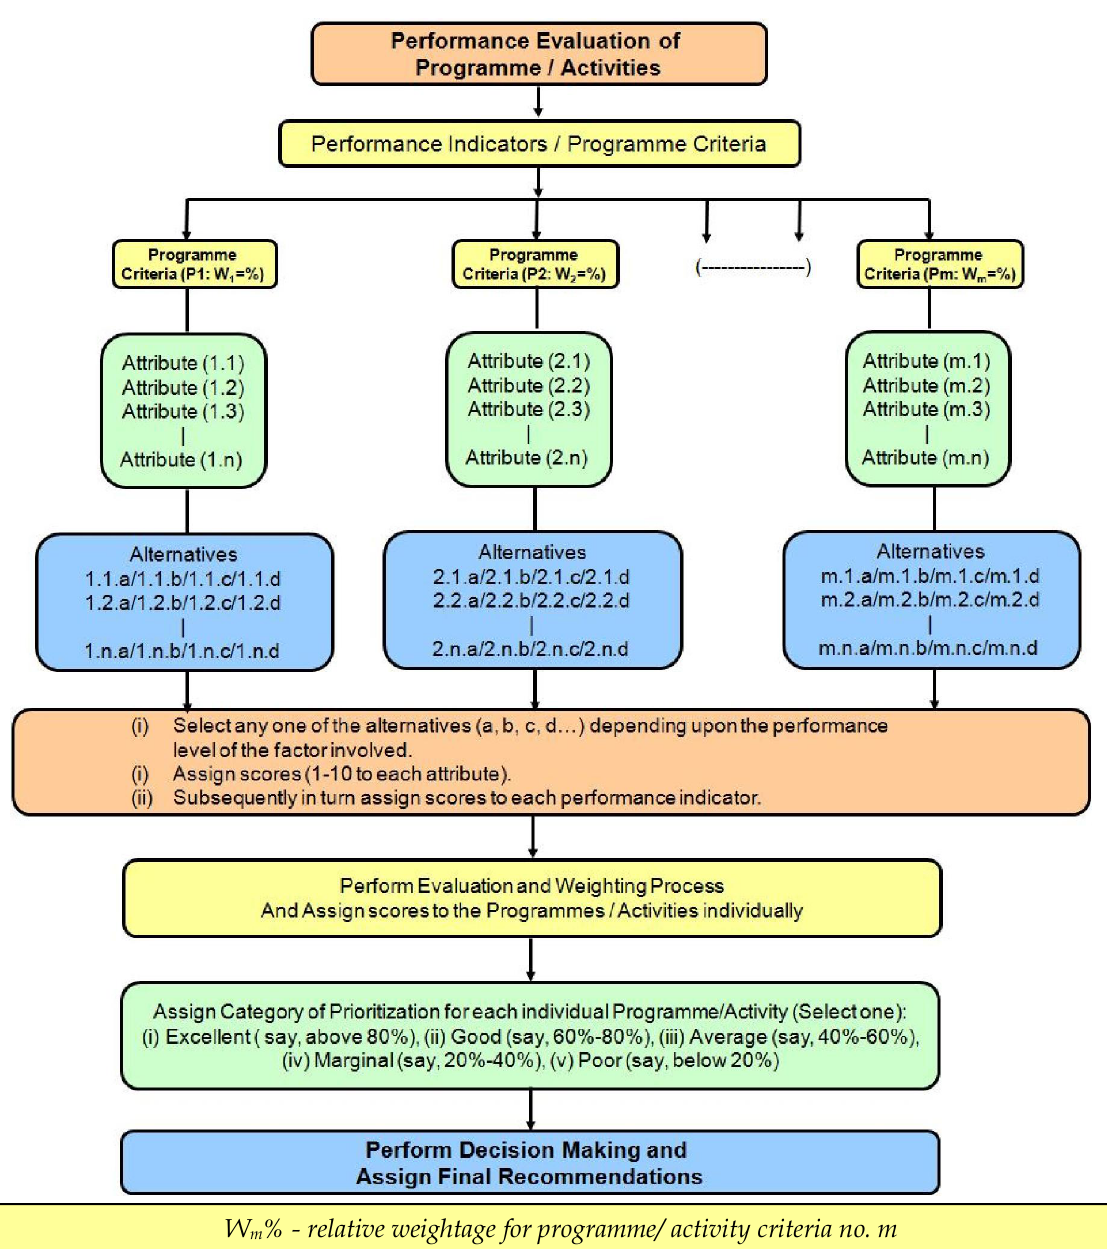
Fig. 5. A DSS model framework for evaluating the performance of Programmes / Activities in ODLIs